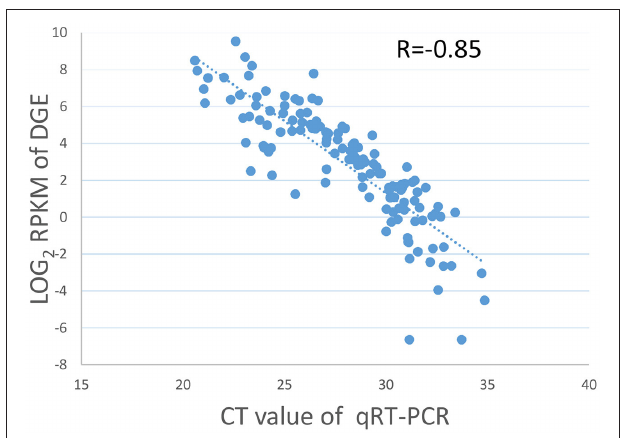
FIGURE 1 | Validation of DGE data by qRT-PCR. Scatter plots indicate the Ct results of the qRT-PCR and the log 2 RPKM values of DGE for 133 data points from 19 genes in 7 different samples with a Pearson correlation coefficient of R = −